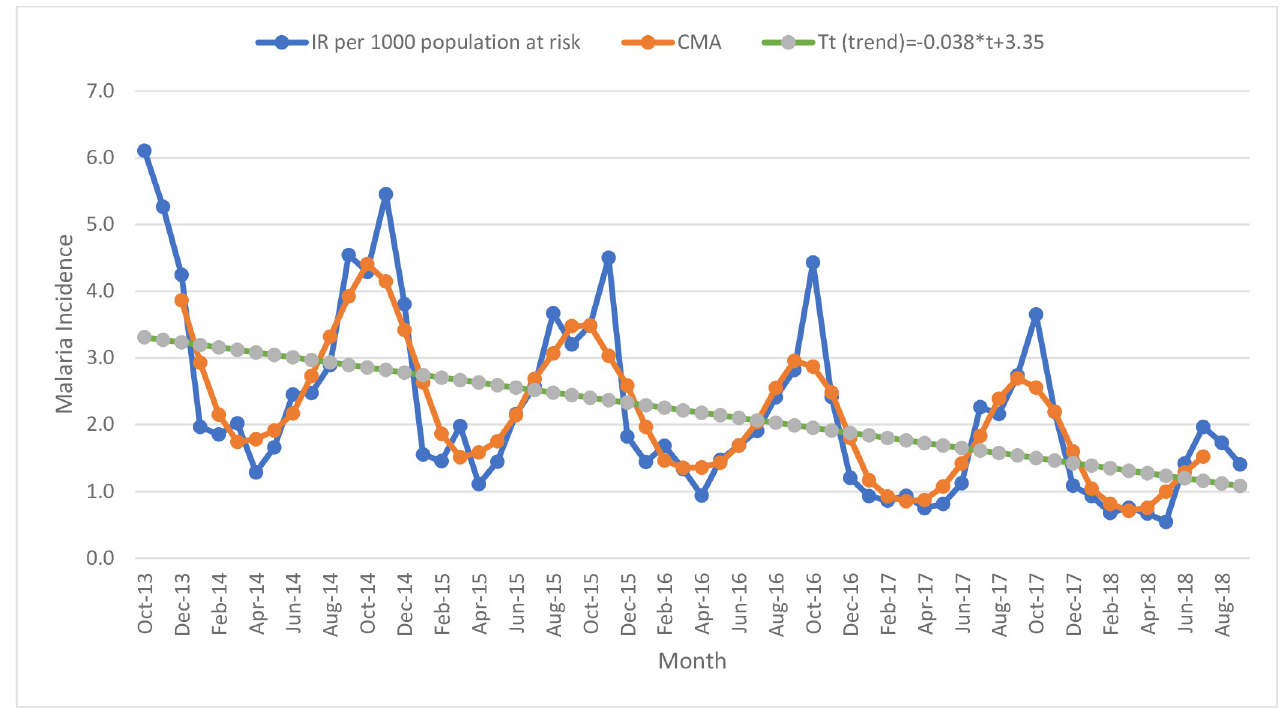
Fig 3. Seasonal decomposition of malaria incidence per 1000 population at risk between September 2013 and 2018 in the non-intervention kebeles.